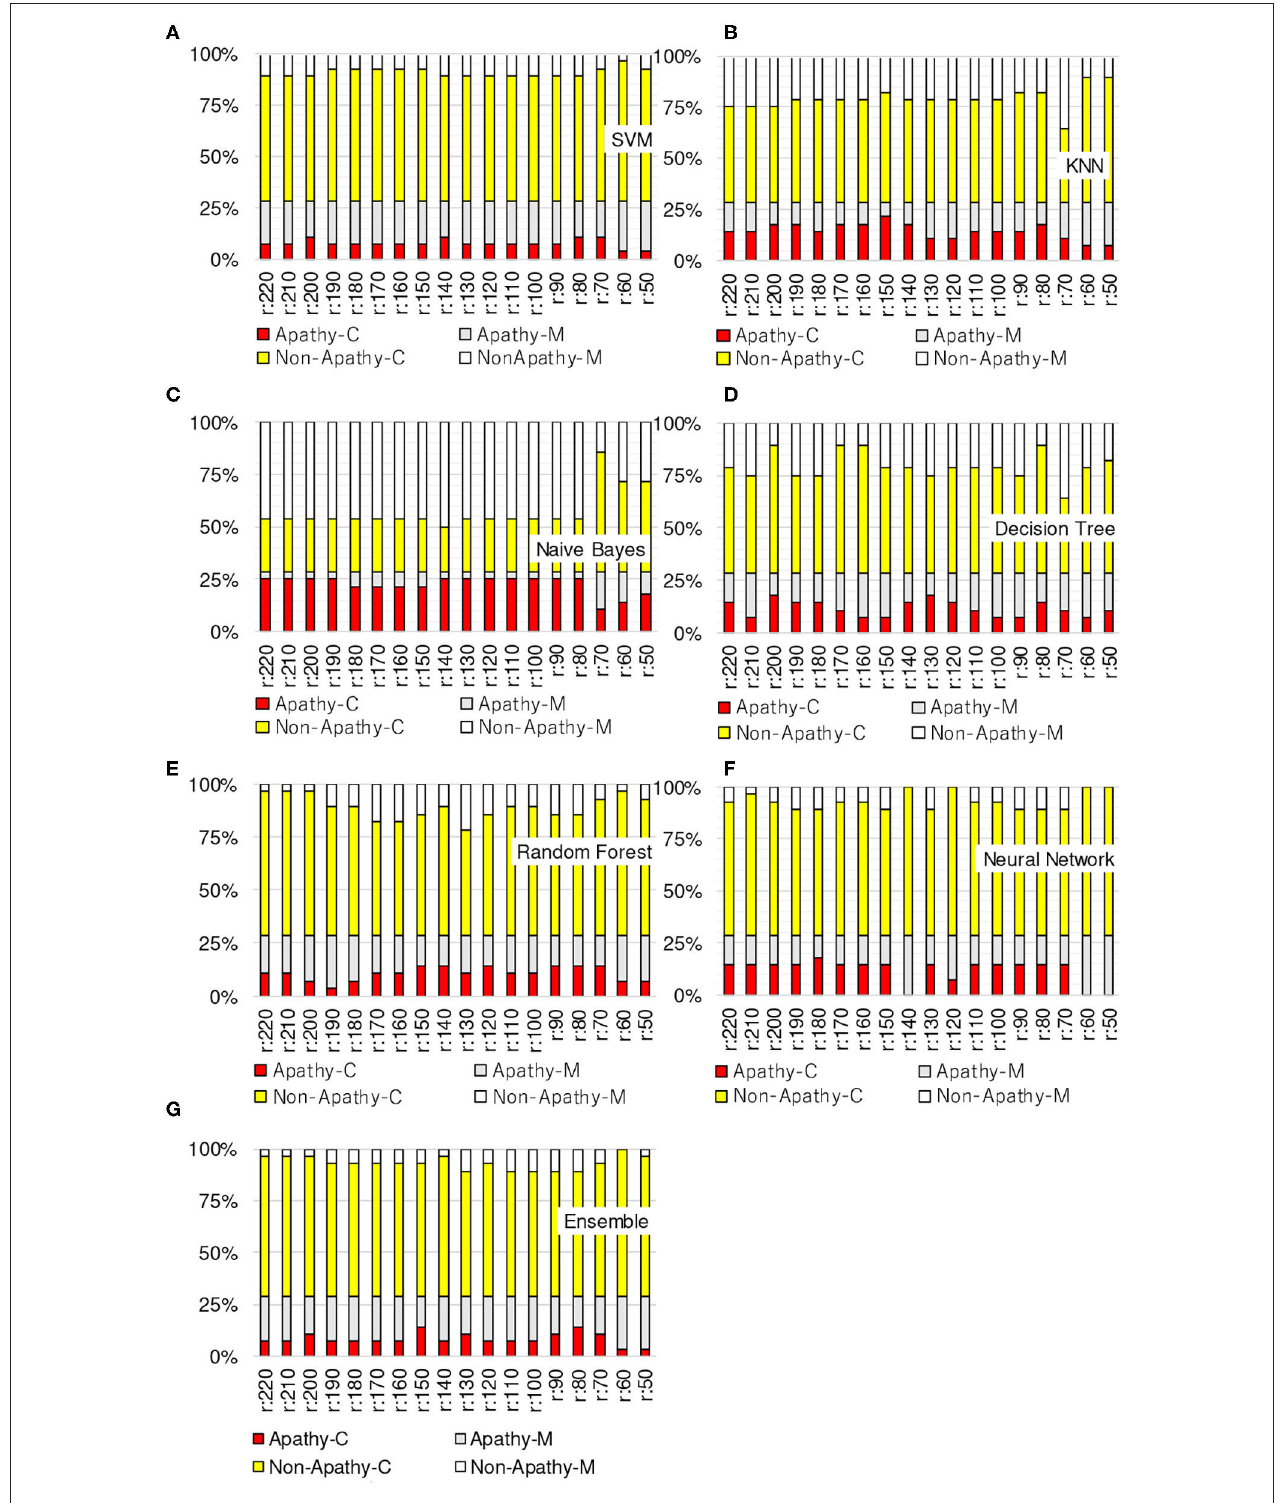
FIGURE 3 | Experimental results: using red channel. (A) SVM, (B) KNN, (C) Naive Bayes, (D) decision tree, (E) random forest, (F) neural network, (G) ensemble.